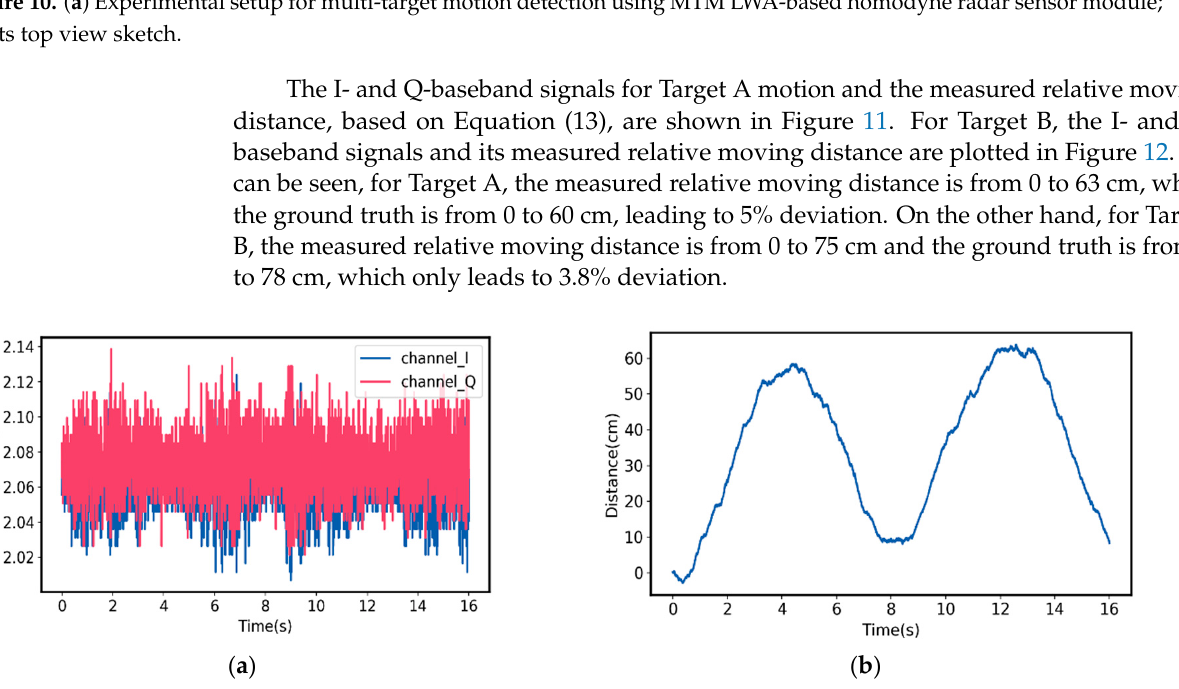
Figure 10. ( a ) Experimental setup for multi-target motion detection using MTM LWA-based homodyne radar sensor module; ( b ) its top view sketch.